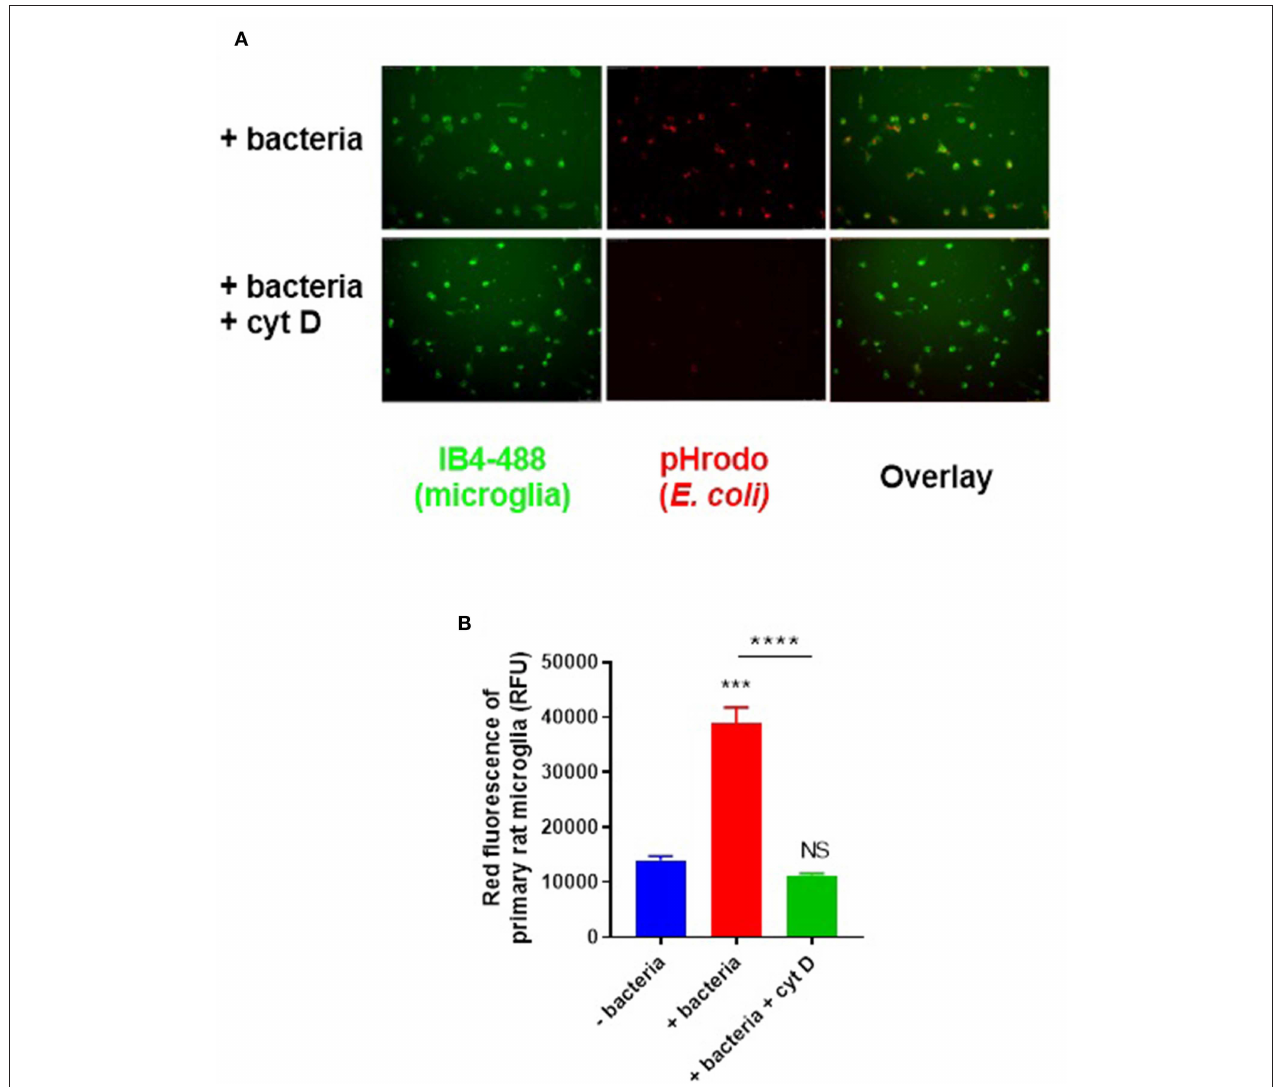
FIGURE 2 | Primary rat microglia rapidly phagocytose E. coli bacteria in vitro . (A) Primary rat microglia phagocytose pHrodo-conjugated E. coli over 60min in culture, which was prevented by cytochalasin D (10 µ M). (B) Microglial phagocytosis of pHrodo-conjugated E. coli was quantified as mean red fluorescence via flow cytometry; there is a significant increase in microglial fluorescence after 60-min with E. coli which is abolished by cytochalasin D, when compared to the “-bacteria” control. Values are means ± SEM of at least three independent experiments. Statistical comparisons were made via one-way ANOVA. NS p ≥ 0.05, *** p < 0.001, **** p < 0.0001 vs. controls, except where indicated by bars over relevant